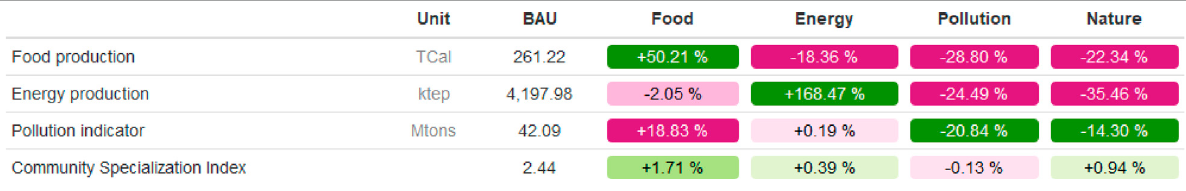
TABLE5Crossedmarginalimpactsofthe4publicpolicyscenariosinregardswiththeBAUonthe4mainobjectives,namely:foodproduction,energy production,pollutionspread,CommunitySpecializationIndex.IndicatorslevelsoftheBAUareexpressedinthespeci fi edunitforreference,while highlightedvaluesarecomputedincomparisontotheBAU.Tablereadsasfollow:foodproductionlevelintheFoodscenariois50%higherthaninthe BAU scenario.